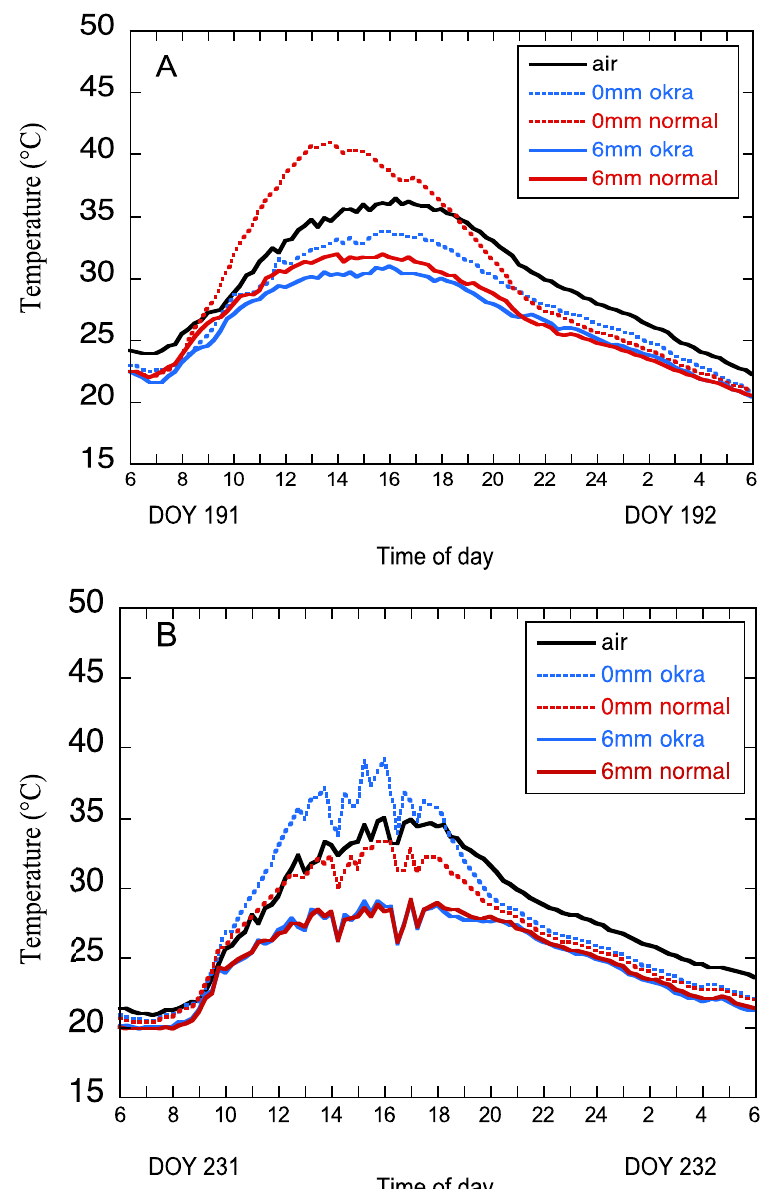
Figure 7. Diurnal pattern of air and canopy temperatures (15 min interval) of okra and normal leaf varieties as a function of time and day for a 24 h period (6 am to 6 am) in four irrigation treatments for DOY 191 ( A ) and DOY 231 ( B ).